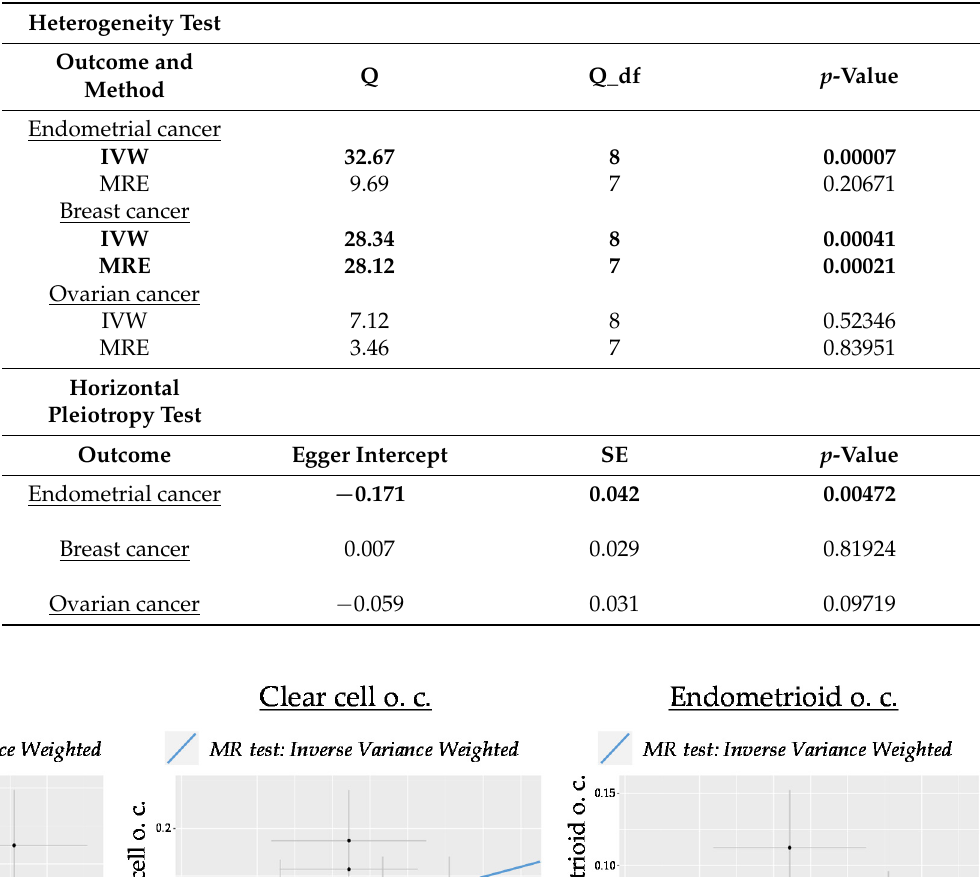
Table 2. Sensitivity tests between endometriosis and endometrial, breast and ovarian cancer, using the Sapkota et al. endometriosis GWAS as exposure. Significant associations ( p -value < 0.05) are highlighted in bold. Q: Cochran’s Q statistic; df: degrees of freedom.